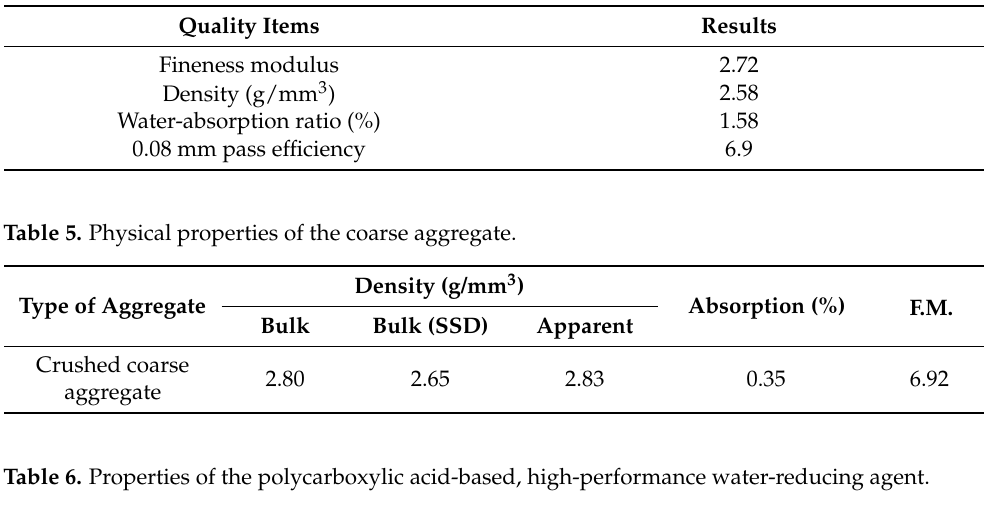
Figure 1. Manufacturing process of air-cooled aggregate for rural-road concrete pavements. Table 4. Quality test result of the crushed fine aggregate.